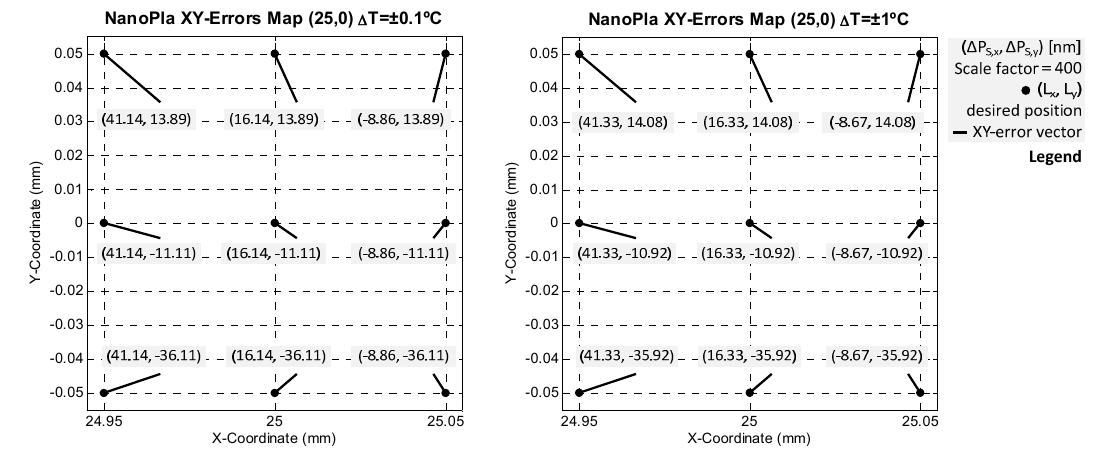
Figure 10. XY-error mapping results (error values in mm) at the (25,0) position, considering different environmental conditions: ( Left ) ∆ T = ±0.1 °C; ( Right ) ∆ T = ±1 °C.